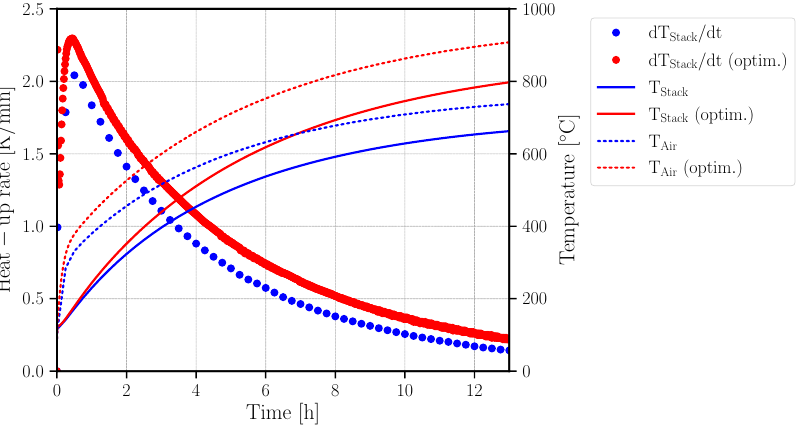
Figure 17. Effect of the optimized heat-up mode on air inlet temperature, stack temperature and heat-up rate of the stack, with 10% more power input at the EAPH and a reduction of the air input by 20% (based on simulated values) for a stack target temperature of 670